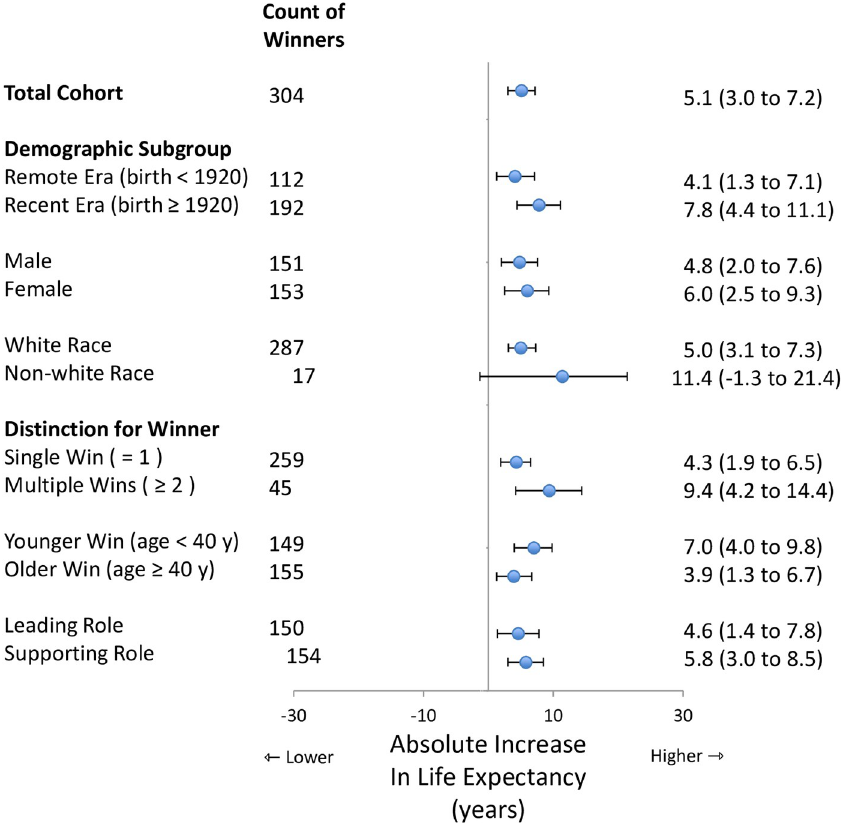
Fig 2. Secondary analysis of winners. Forest plot showing multiple sensitivity analyses of absolute increase in life- expectancy for winners in different subgroups. Referent group in all analyses is control performers with no win and no nomination. Circles denote estimate and horizontal lines denote 95% confidence interval. Vertical line for null association marked as a 0 year increase in life expectancy. Sample size in each analysis shown as corresponding count of winners. Findings suggest increased life-expectancy for winners compared to